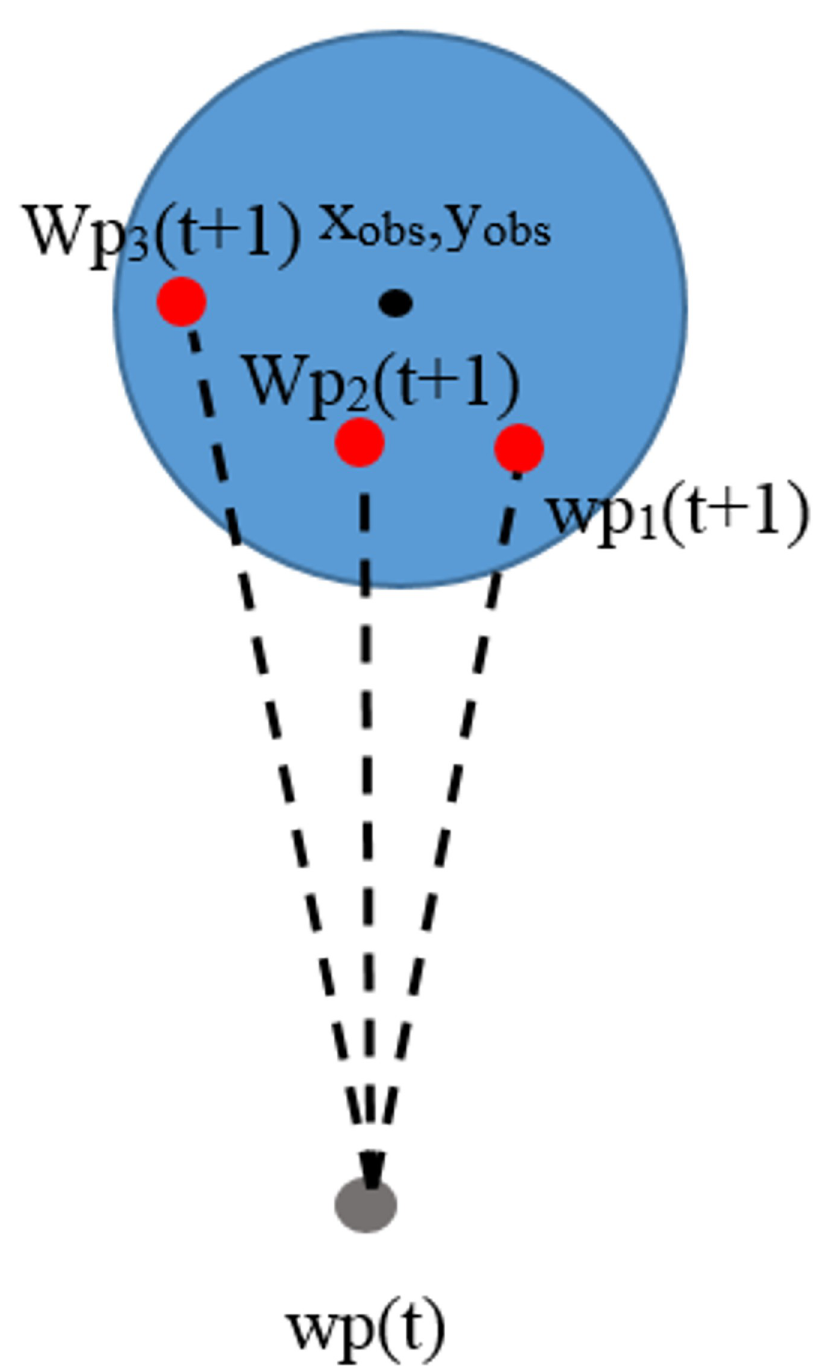
Fig 12. Infeasible waypoints when the points are in